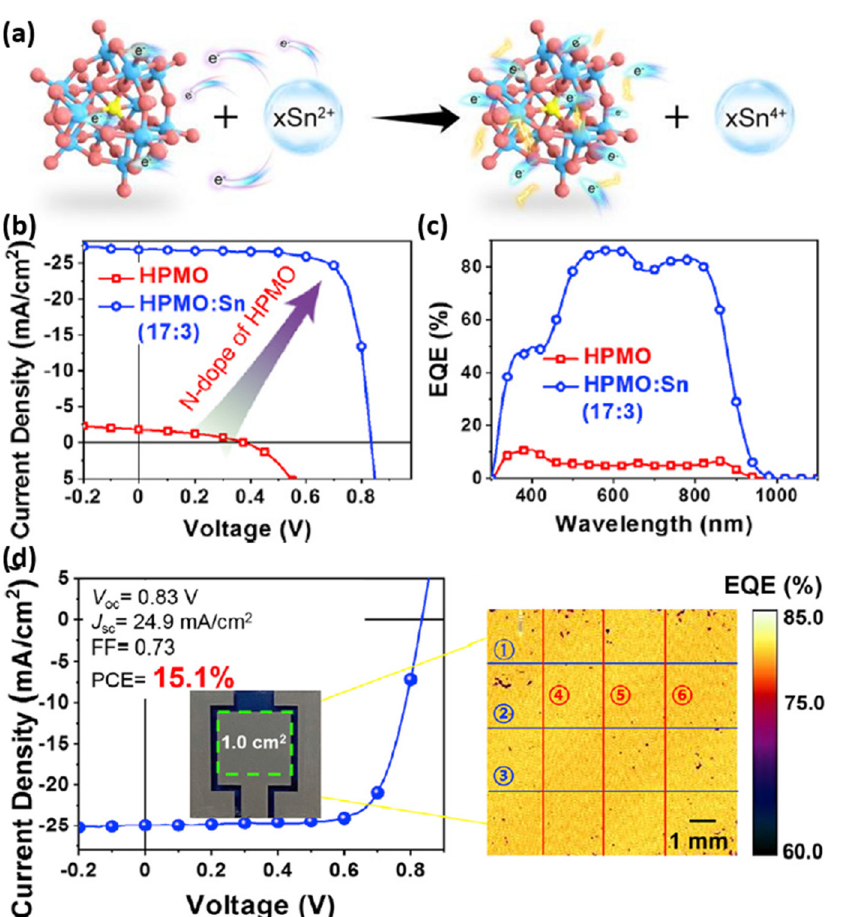
Figure 14. ( a ) Diagram of the reaction. ( b ) J - V curves and ( c ) EQE spectra of corresponding OPVs. ( d ) J - V curves and photovoltaic parameters of 1 cm 2 OPVs. Mapping image of EQE at 500 nm. Reproduced from [111]. Reprinted with permission from ref. [111]. Copyright 2021 Elsevier.